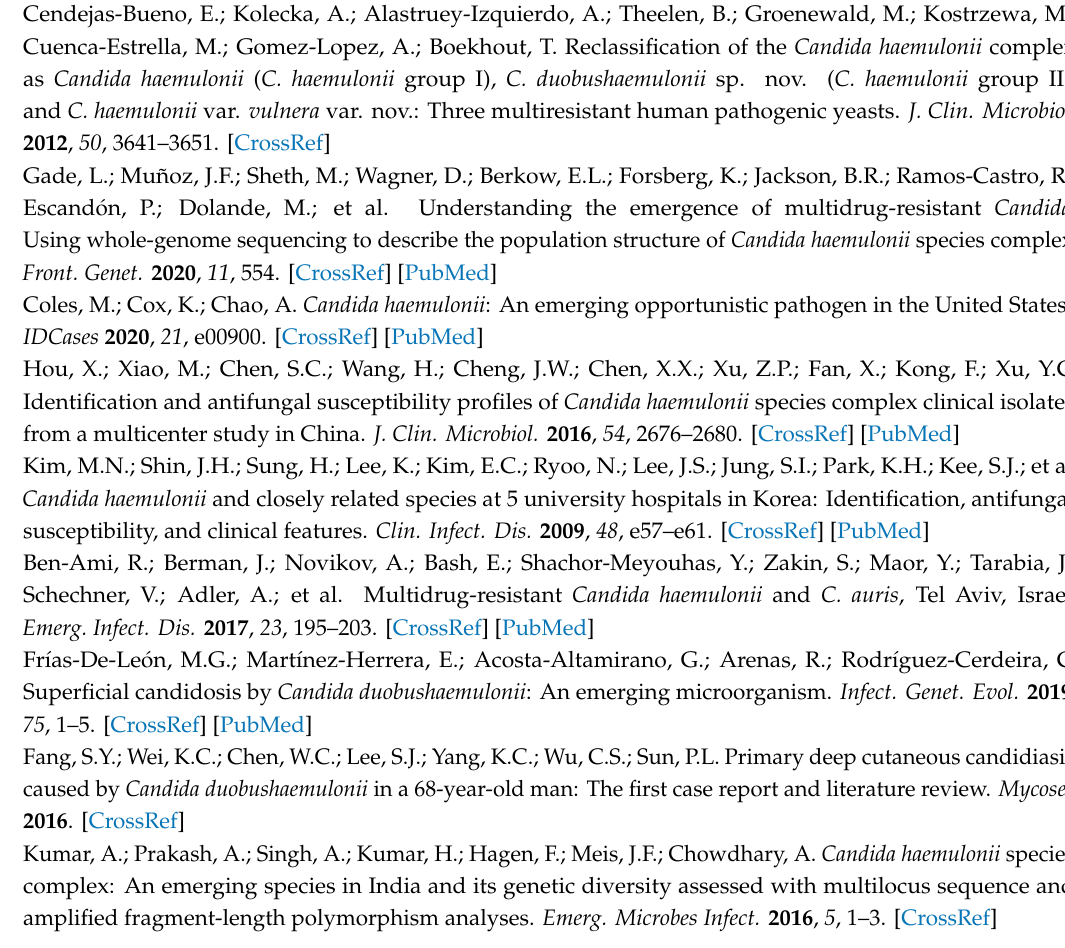
Table S1: Antifungal susceptibility profiles of the clinical isolates belonging to the Candida haemulonii species complex to di ff erent azole agents, Table S2: Antifungal susceptibility profiles of the non- albicans Candida species to di ff erent azole agents, Table S3: Homology search results comparing Candida albicans (SC5314) and Candida haemulonii (B11899) genes via